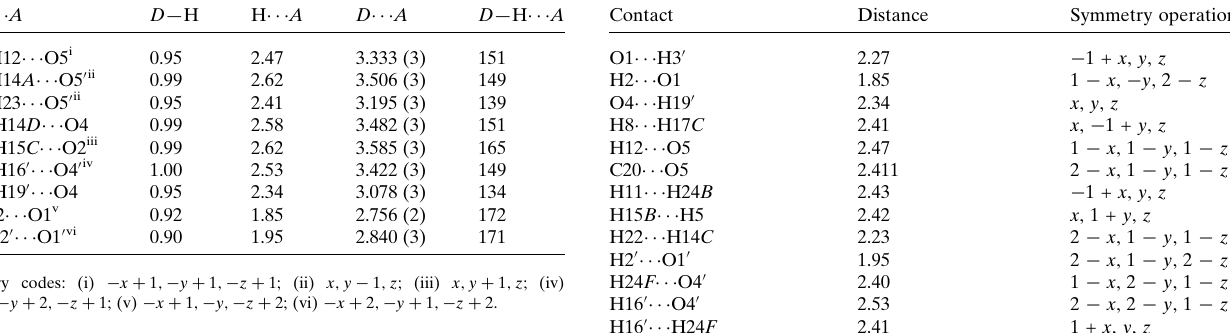
Table 2 Summary of short interatomic contacts (A˚ ) in the title compound 3 .